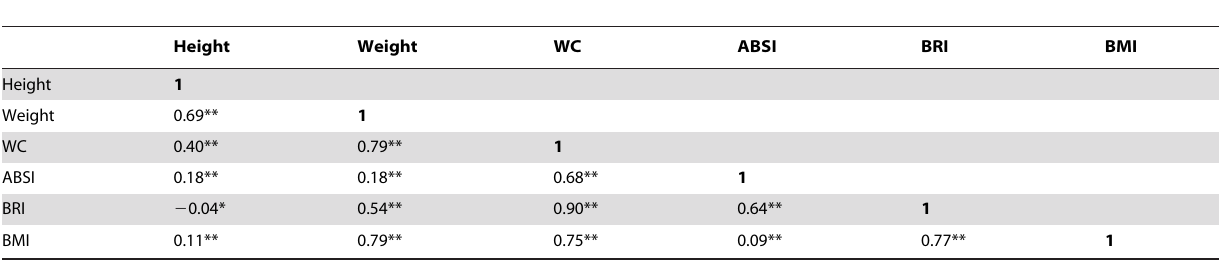
Table 2. Correlations between body size and